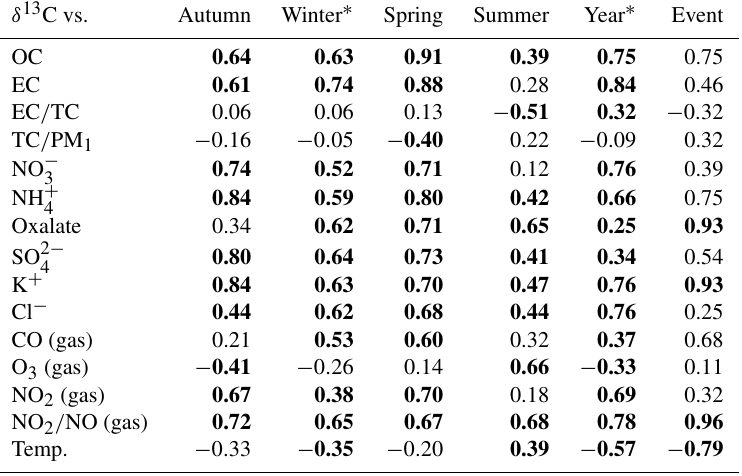
Table 3. Spearman correlation coefficients ( r ) of δ 13 C with various tracers. Only bold values are statistically significant ( p values <0.05). δ 13 C vs.